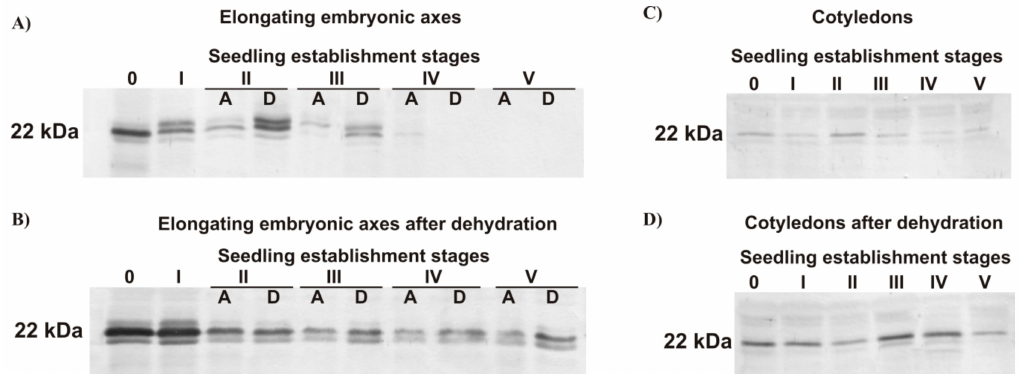
Figure 5. Detection of small heat shock protein (sHSP) in the elongating embryonic axes ( A , B ) and cotyledons ( C , D ) of germinated seeds and at early seedling establishment stages of Fagus sylvatica by Western blotting with antibodies specific to the Arabidopsis 17.4 sHSP before ( A , C ) and after dehydration to 11% of water content ( B , D ). Soluble protein extracts (12.5 µ g) were used. Each image is representative of three independent experiments with similar results. A, apical part of the elongating embryonic axes containing root tip of the radicle, D, distal part of the elongating embryonic axes containing hypocotyl. 3.5. ROS Production.